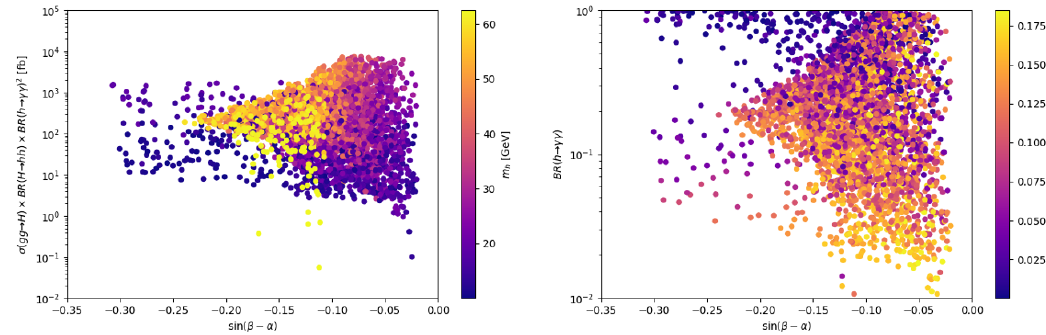
Figure 2. (Left) The (cid:27) 4 (cid:13) rate as a function of sin( (cid:12) (cid:0) (cid:11) ) with m h indicated on the right vertical axis. (Right) The BR( h ! (cid:13)(cid:13) ) as a function of sin( (cid:12) (cid:0) (cid:11) ) with BR( H ! hh ) indicated on the right vertical axis. Both plots are for scan-1.